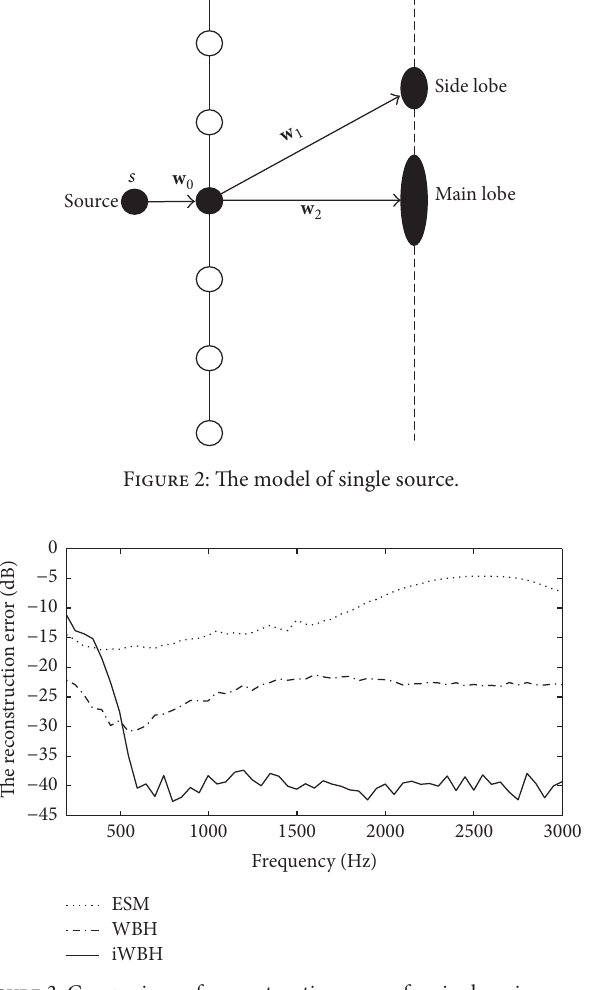
Figure 3: Comparison of reconstruction errors for single noise